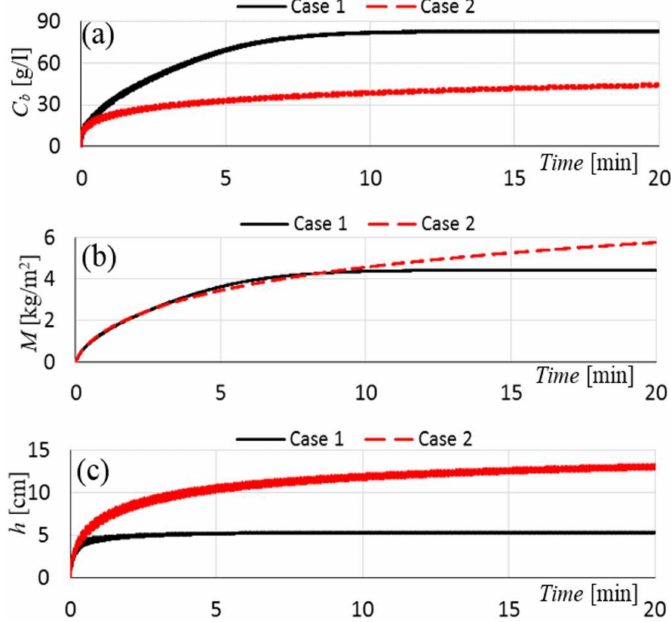
Figure 14. Same as Figure 7 with C * = 180 g/L, but showing results for case 1 (solid black lines; S ε = 0) and case 2 (dashed red lines; S b = 0). Sediment stratification effects have a dominant impact on lutocline